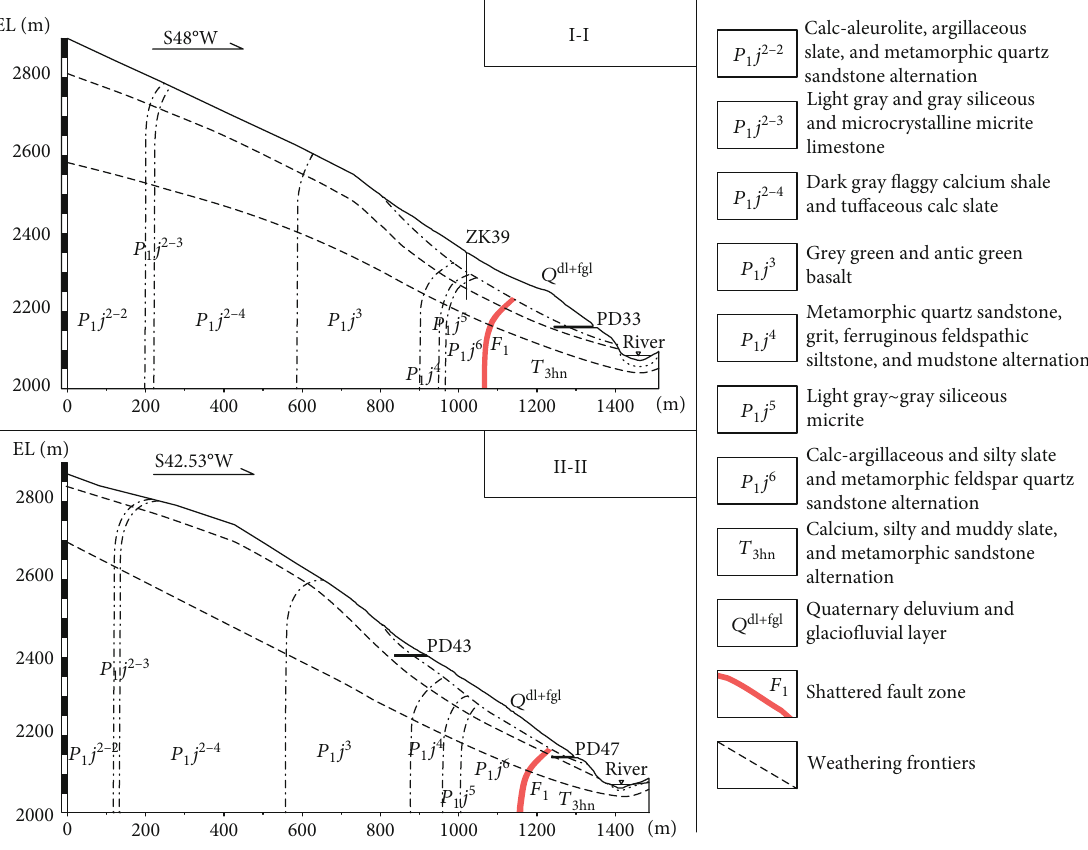
Figure 5: Two engineering geological pro fi les of the glacio fl uvial